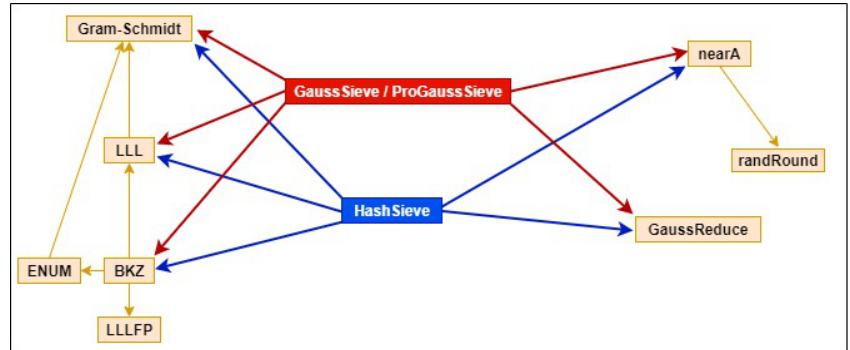
Figure 1. The algorithmic framework of the sieving and enumeration